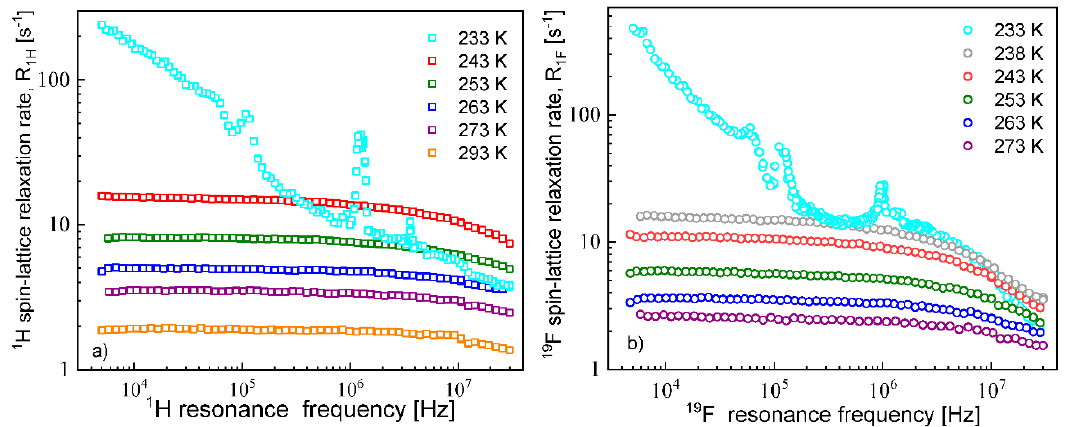
Figure 1. 1 H ( a ) and 19 F ( b ) spin–lattice relaxation ratesfor 1-ethyl-3-methylimidazolium bis(fluorosulfonyl)imide (EMIM-FSI) in